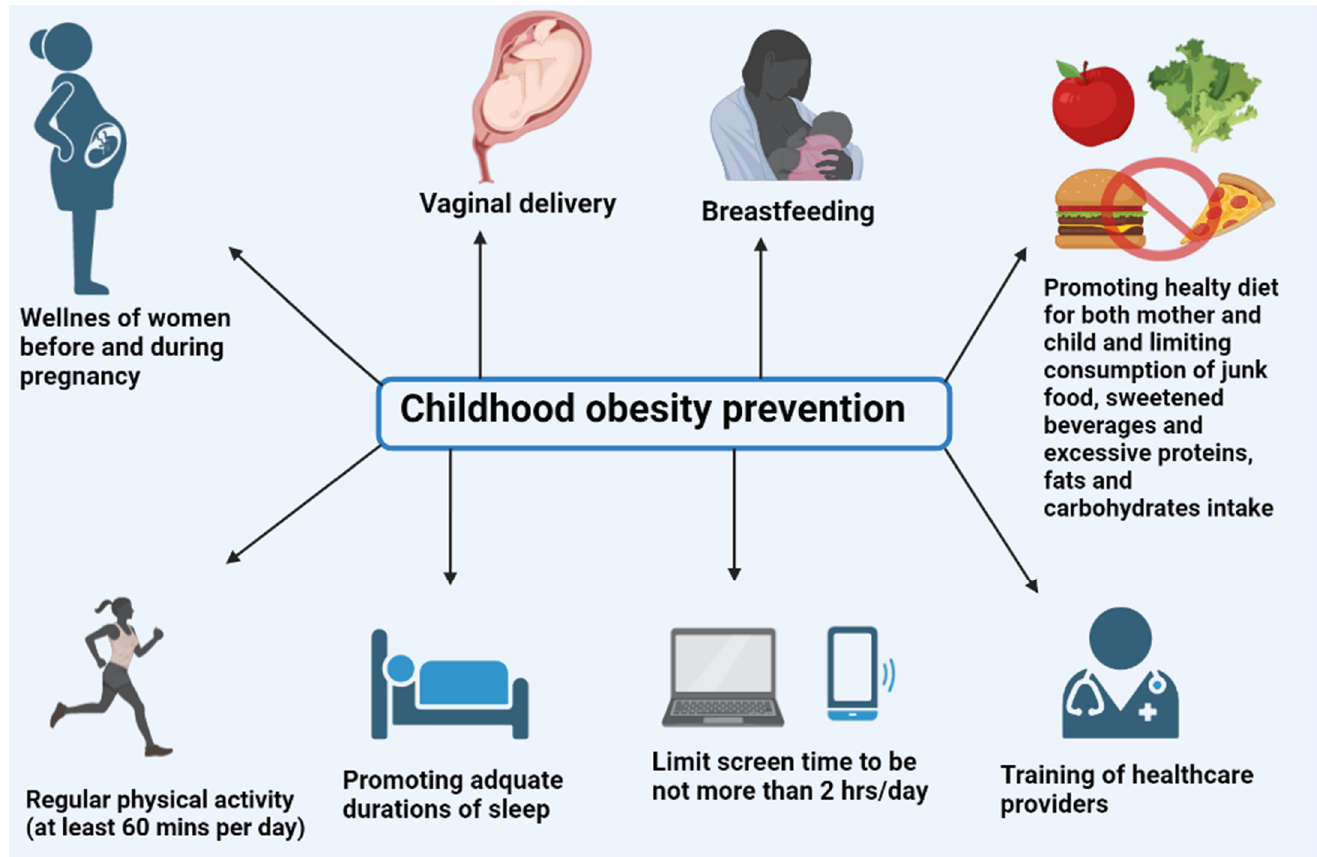
Figure 1. Childhood obesity prevention.